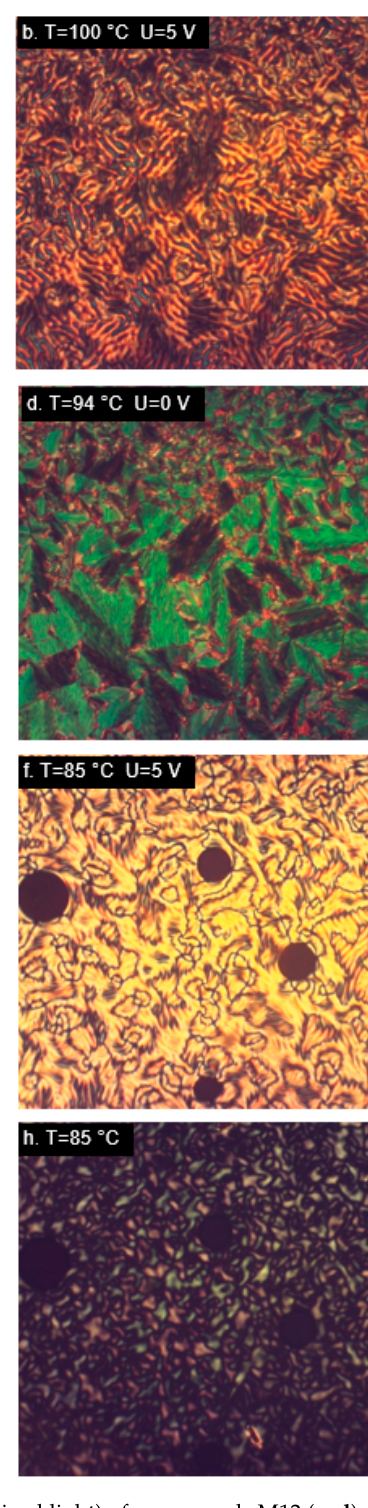
Figure 7. Microphotographs (in cross-polarized light) of compounds M12 ( a – d ) and MU12 ( e – h ) in nematic ( a – c , e – h ) and smectic phase ( d ), showing alignment changes due to electric field. Samples placed in cells with layers inducing homeotropic orientation. ( h ) Vanishing of alignment after switching off the electric field.